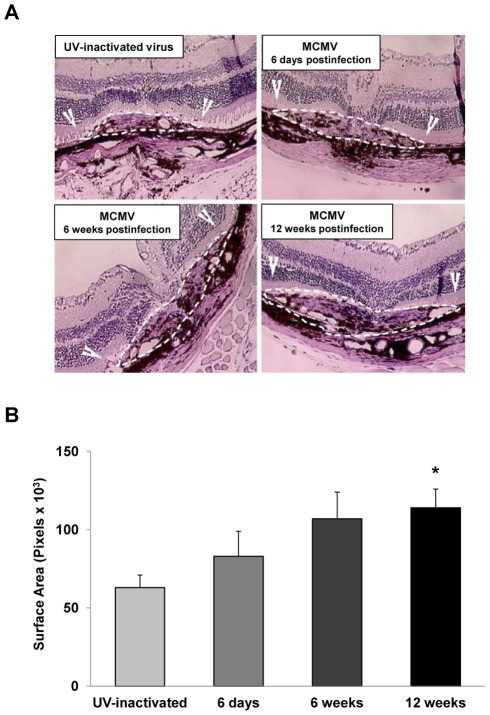
Eyes of mice with chronic MCMV infection show more severe CNV as determined by histopathologic analysis.Groups of adult C57BL/6 mice were inoculated intraperitoneally with either MCMV or UV-inactivated virus. At 6 days, 6 weeks, or 12 weeks after inoculation, all mice were subjected to laser treatment to induce CNV, and, four weeks later, retinal sections were subjected to histopathologic analysis. (A) Hematoxylin and eosin-stained histopathologic sections of representative individual mouse retinas four weeks after laser treatment showing areas of CNV (white outlines and arrows). (Magnification = 100×) Mouse inoculated with UV-inactivated MCMV (control); mouse infected with MCMV for 6 days prior to laser treatment; mouse infected with MCMV for 6 weeks prior to laser treatment; mouse infected with MCMV for 12 weeks prior to laser treatment. (B) Comparative quantitative analysis of all animals of each group for size of CNV areas as determined by histopathologic analysis. Asterisk indicates statistical significance when compared with control (p = <0.0004).